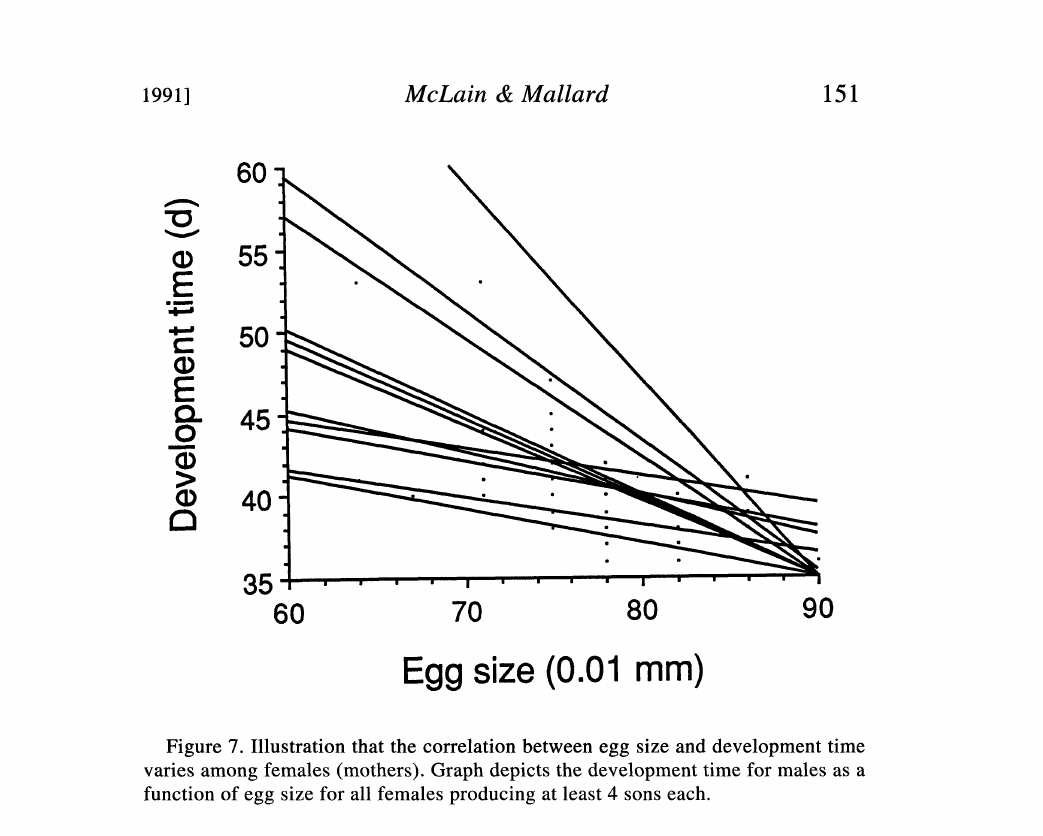
Figure 7. Illustration that the correlation between egg size and development time varies among females (mothers). Graph depicts the development time for males as a function of egg size for all females producing at least 4 sons